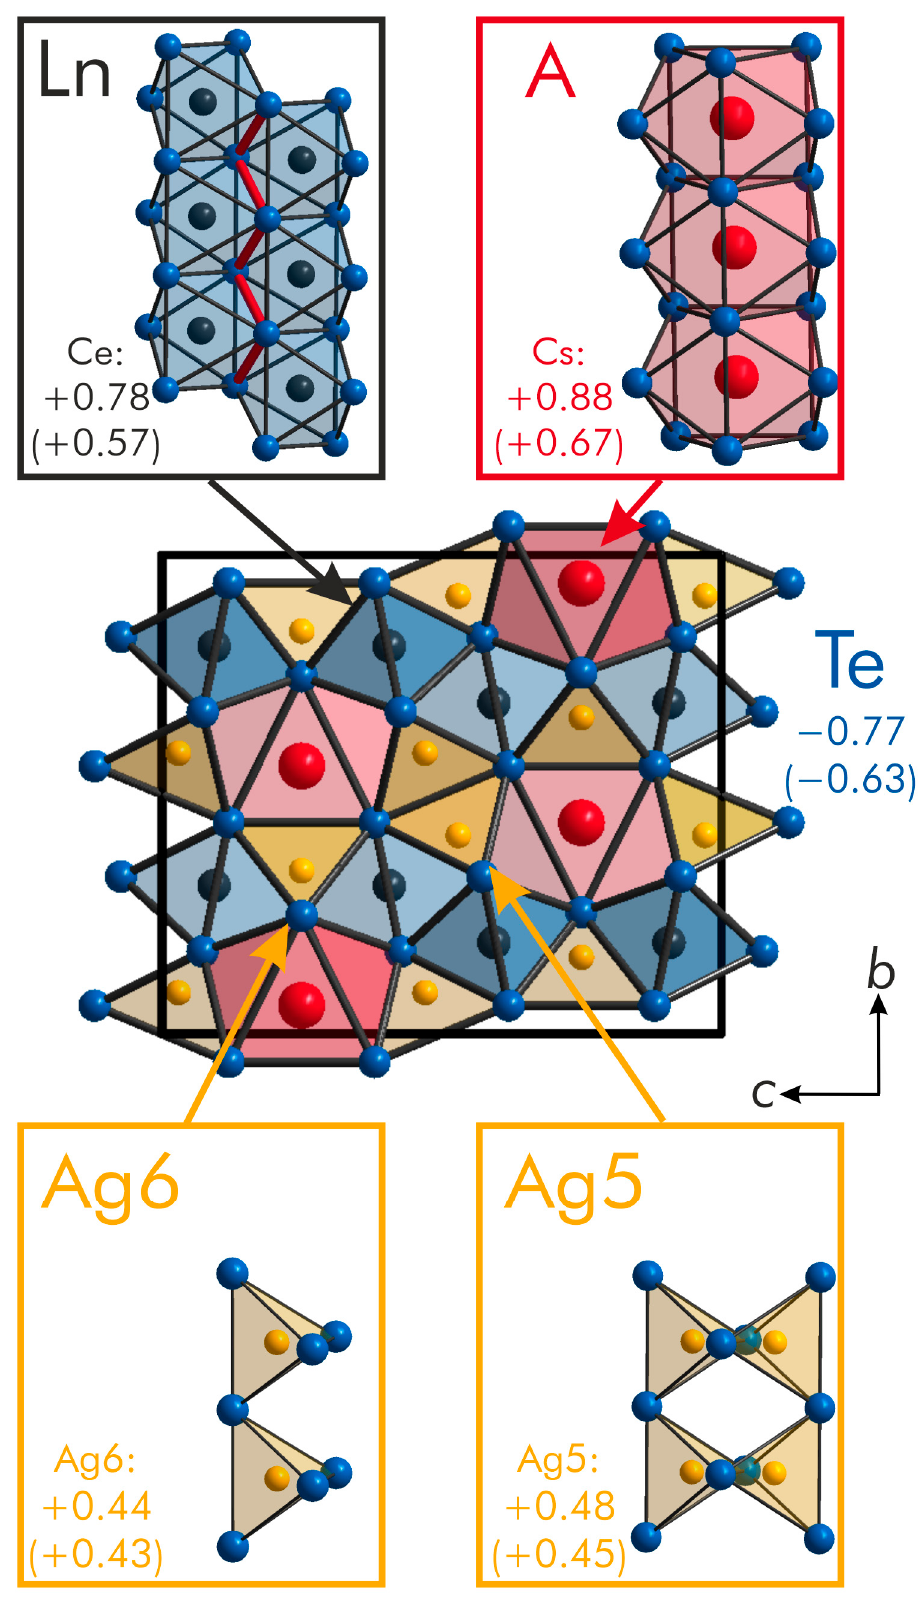
Figure 3. Representation of the crystal structure of the ALn 2 Ag 3 Te 5 -type tellurides: the diverse types of tellurium polyhedra surrounding the alkaline-metal (A), lanthanide (Ln), and silver atoms are shown in the insets, also including the Mulliken and Löwdin charges (in parentheses) which have been calculated for CsCe 2 Ag 3 Te 5 . The Mulliken (and Löwdin) charges of tellurium, which vary by ± 0.01 (and ± 0.02) for the di ff erent tellurium positions, represent the average charge